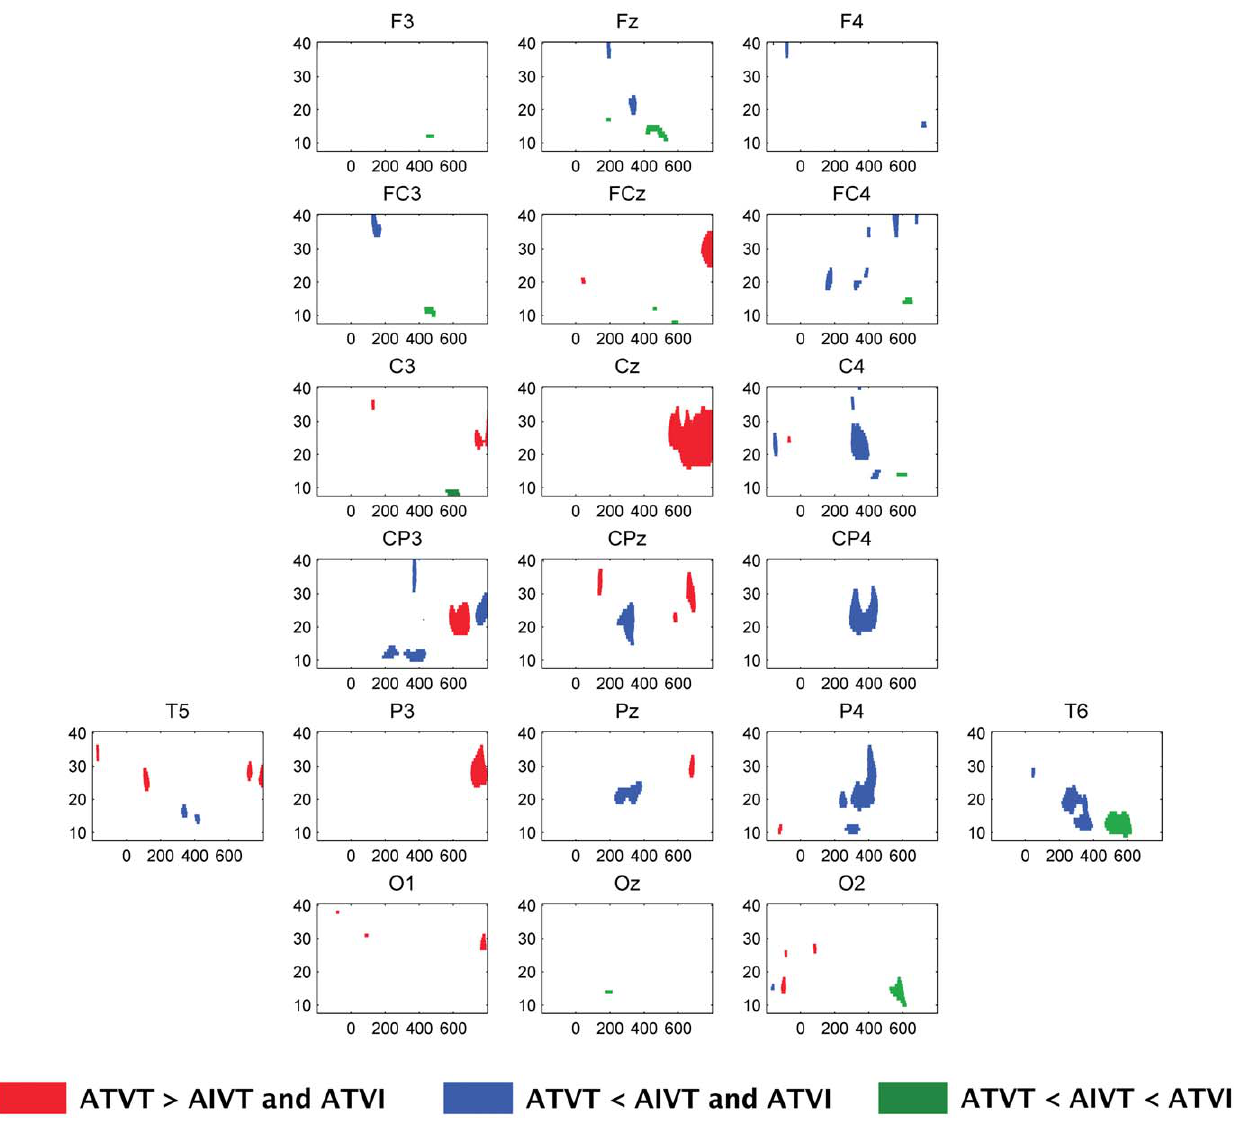
Figure 8. Time-frequency maps of showing areas related to multisensory facilitation. Time-frequency maps depicting regions where the ATVT stimulus was significantly different from both the ATVI and AIVT stimulus. Significant differences were identified using a bootstrap procedure with alpha set at .01.